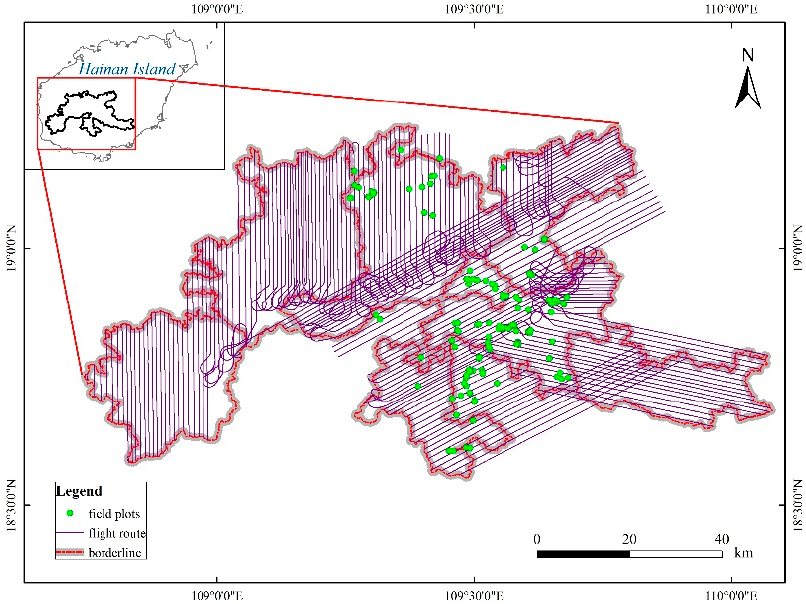
Figure 1. Location of the study area and the distribution of sample plots.